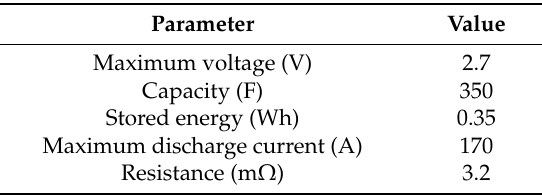
Table 4. Basic parameters of the SC